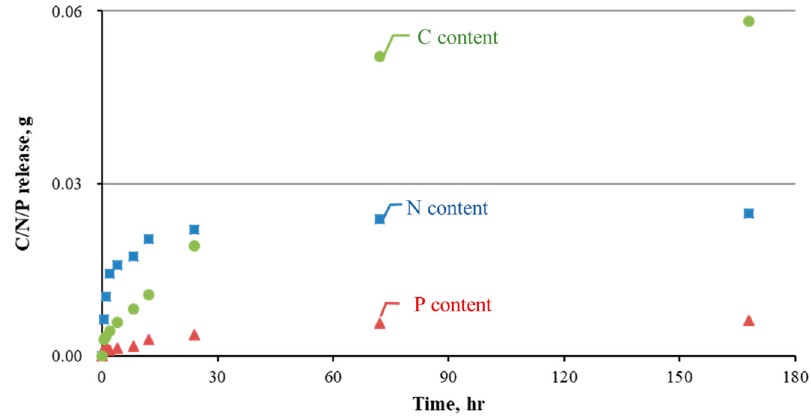
Figure 4. Release of C, N, and P over the treatment period.